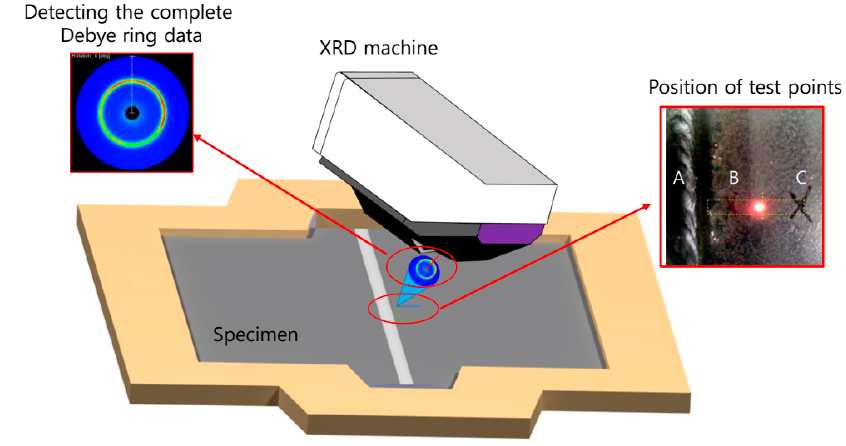
Figure 5. Experimental setup of the XRD measurement.